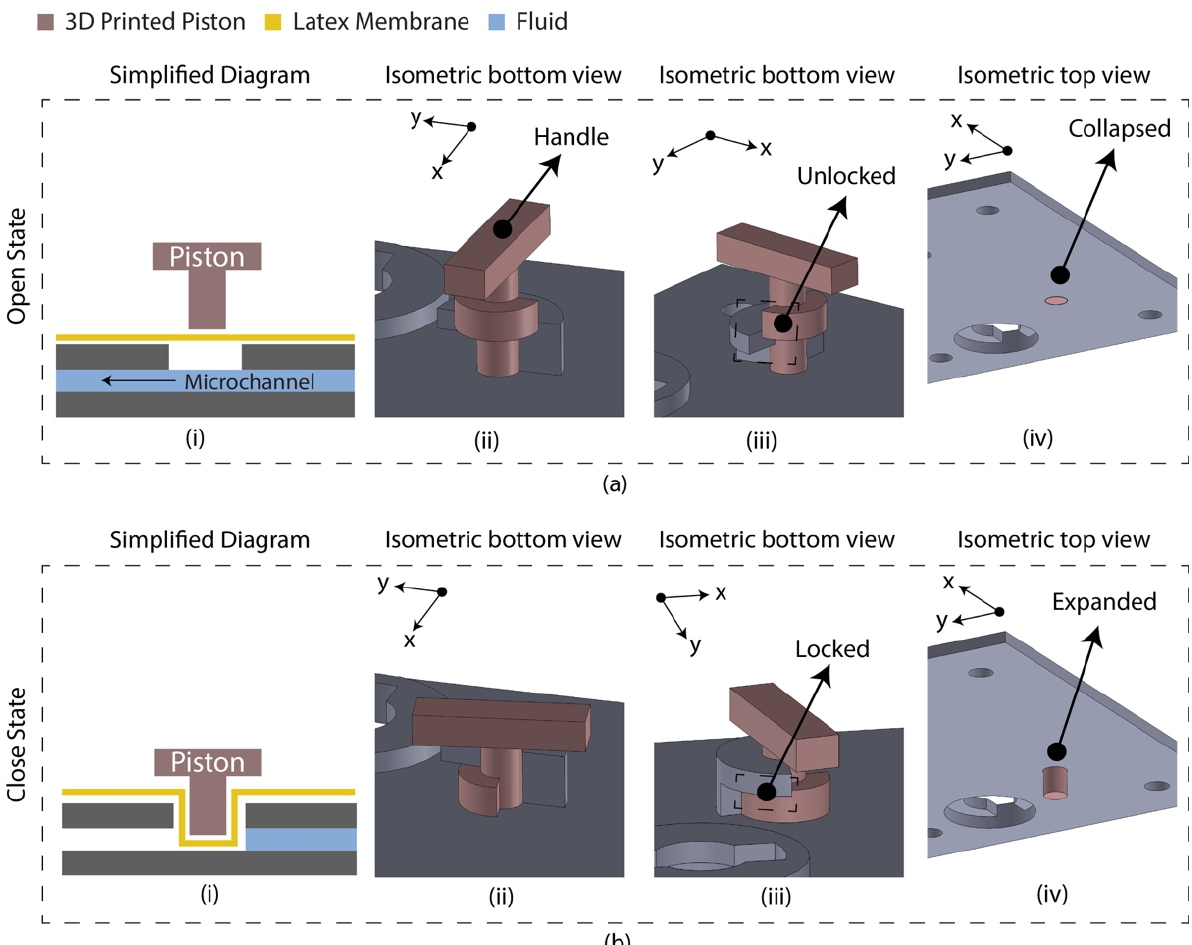
Figure 1. Latex membrane-based micro-valve design in two operating states. ( a ) Open state. The piston requires anticlockwise rotation (90°) and pulling to change state from close to open; (i) simplified diagram indicating the floated piston on the latex membrane allowing the fluid to flow; (ii) isometric view of the valve indicating the handle for manual control; (iii) isometric view indicating the unlocked/pulled condition; (iv) isometric view (isolated) indicating the collapsed condition of the piston. ( b ) Closed state. The piston requires pushing and clockwise rotation (90°) to change state from open to close; (i) simplified diagram indicating the piston blocked the microchannel deforming the latex membrane; (ii) isometric view of the valve; (iii) isometric view indicating the locked/pushed condition; (iv) isometric view (isolated) indicating the expanded condition of the piston.